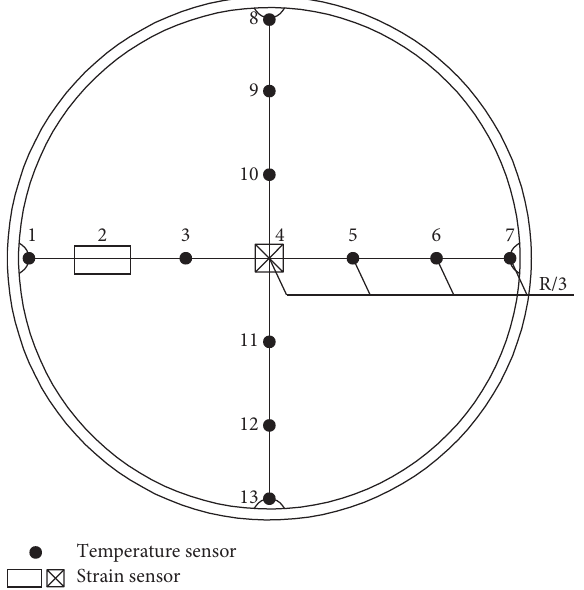
Figure 7: Measuring point layout.